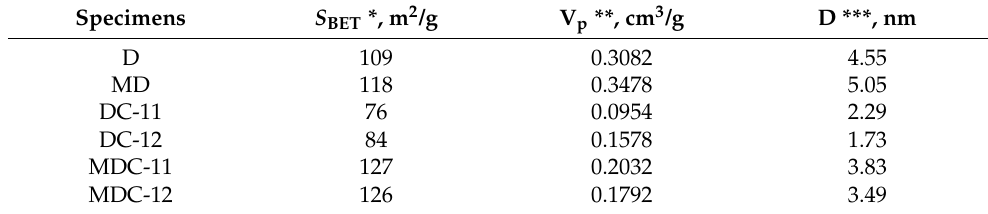
Table 1. Surface characteristics properties of diatomites and CeO 2 -diatomite composites. Specimens S BET *, m 2 /g V p **, cm 3